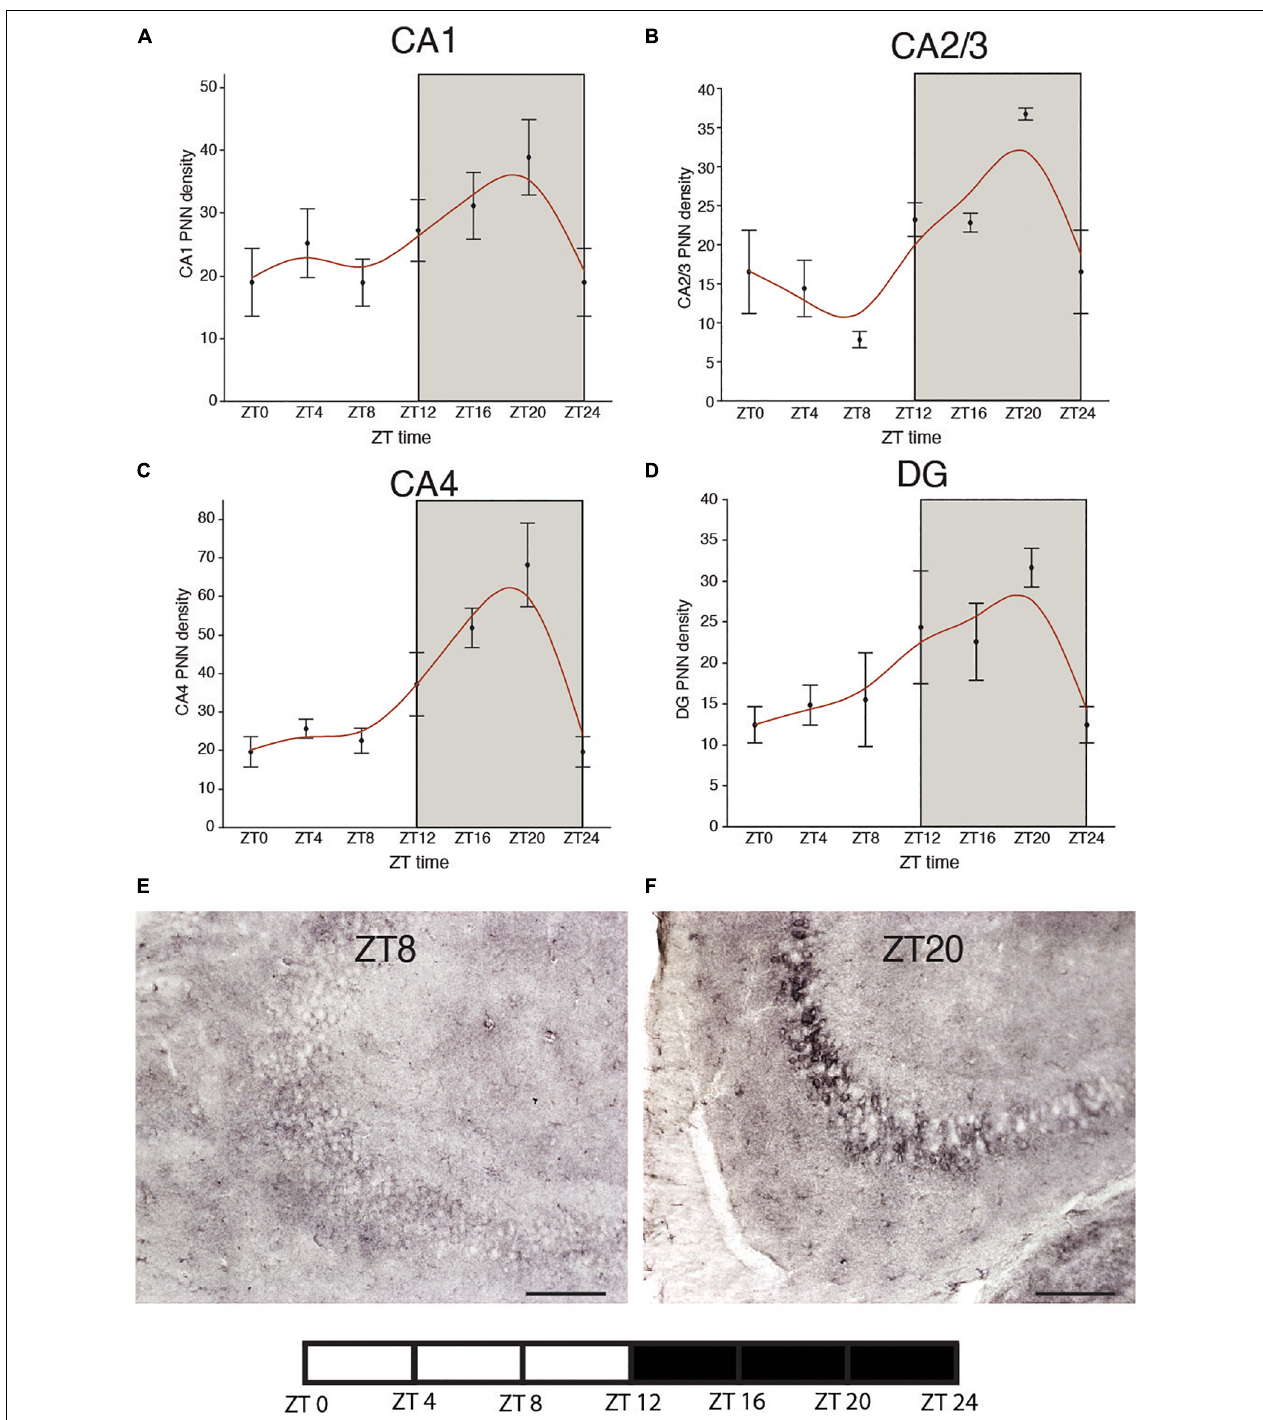
FIGURE 2 | Diurnal rhythms of chondroitin sulfate synthase 1 labeled perineuronal nets in the mouse hippocampus. CHSY1 immunoreactive PNNs were labeled with rabbit anti-CHSY1antibody (cat#14420-1-AP, ProteinTech) at 1:500 µ l dilution. Immunolabeling and quantification was conducted on serial sections from the same mice in our previous study according to the same methods described in detail (Pantazopoulos et al., 2020a). Diurnal rhythms of chondroitin sulfate synthase 1 (CHSY1) immunoreactive PNNs were observed in hippocampal sector CA1 (A) CA2/3 (B) , CA4 (C) and the dentate gyrus (D) , with peaks at ∼ ZT20 and troughs at ∼ ZT8. Error bars represent standard deviation. Representative low magnification images of CHSY1 labeling in the mouse hippocampus at ZT 8 (E) and ZT 20 (F) .